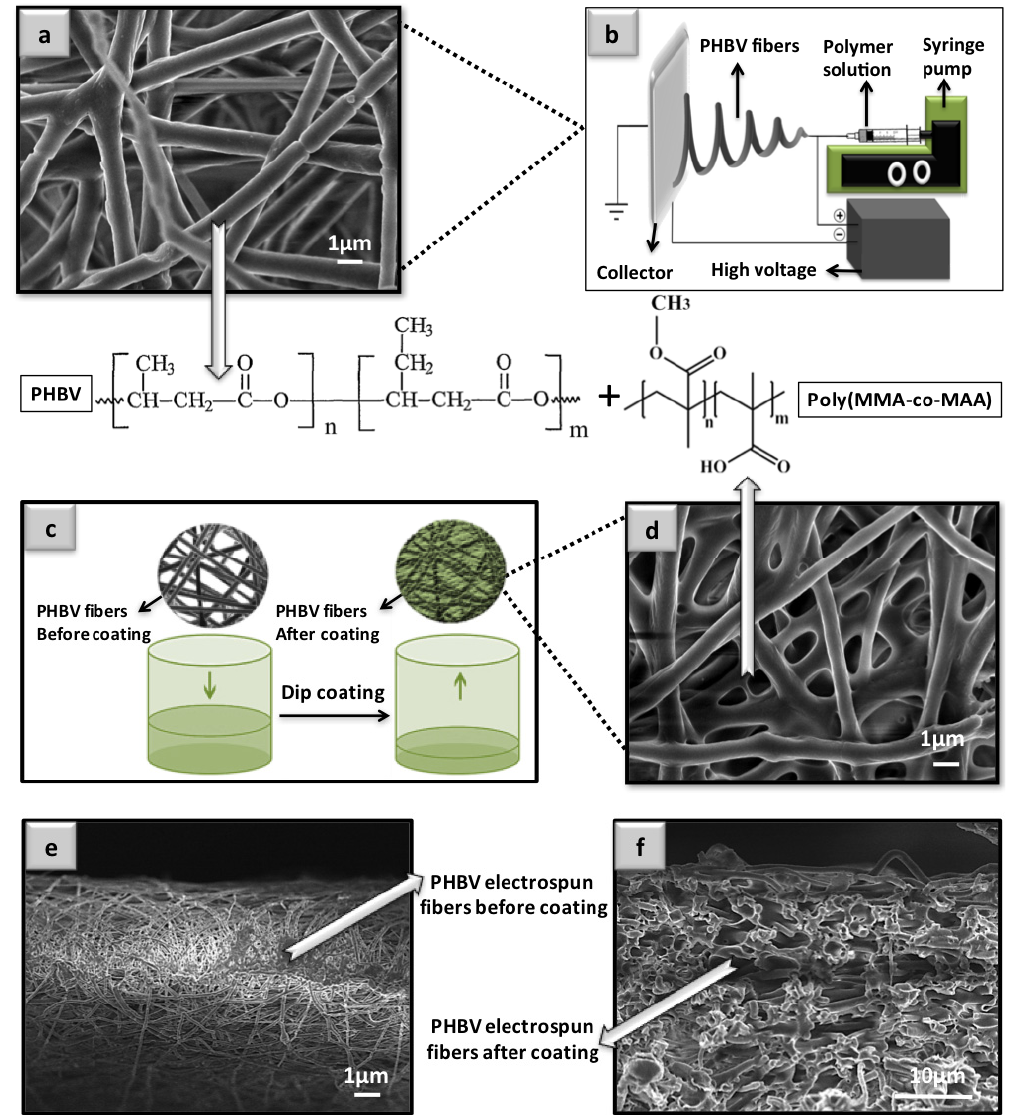
Figure 1. Schematic presentation of the procedure for fabrication of the polymer ‐ coated PHBV (poly